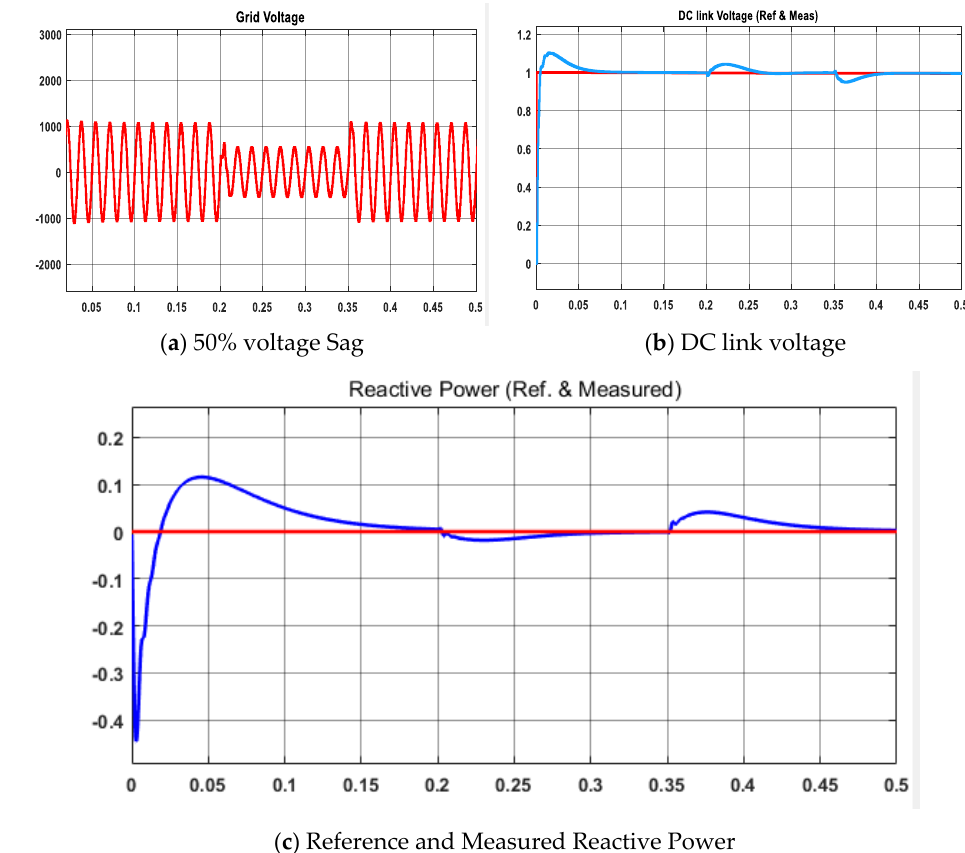
Figure 16. Controller performance under symmetrical 50% voltage sag.